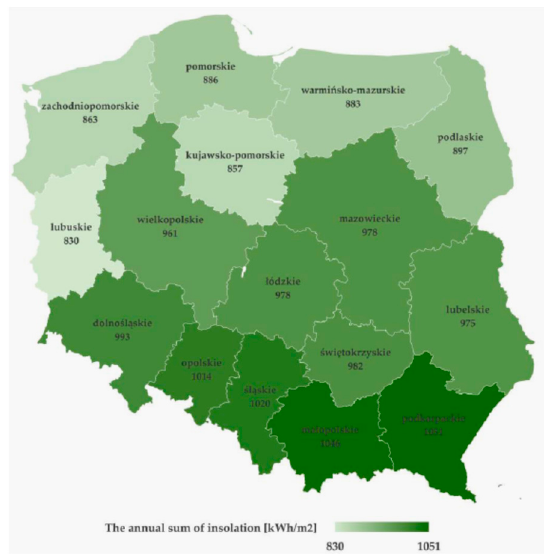
Figure 1. The annual sum of insolation in particular voivodships–data from [58]. Poland’s insolation does not differ greatly from the insolation of Central European countries and areas in similar latitudes. From the point of view of using solar energy by photovoltaic installations, the most important parameter is the annual value of insolation, which defines the quantity of solar energy per unit of flat area in a specified period. When considering this parameter, it can be stated that the solar conditions in Poland differ greatly regionally—the annual density of irradiance fluctuates between 800 and 1200 kWh/ m 2 . Such a number of sunrays is enough to meet 60% (in winter) and 100% (in sum- mer months) of electricity demand [59]. 2.3. Investment Outlays and Operational Costs of Photovoltaic Installations In order to evaluate the economic efficiency of an undertaking, it is necessary to com- pare the level of income (benefits) that results from its implementation with its costs, in- cluding the investment outlays that are related to its creation, according to the NPV method. The evaluation presented in this paper was made with fixed current prices (level of prices from the first half of 2020). The calculations of values of other authors expressed at other levels were updated with the application of the consumer price index [60], as well as the European Union Consumer Price Index (CPI) [61]. The basis for calculating the con- version rate of PLN into Euro was the average exchange rate for the Euro for the first half of 2020 [62]. The value of investment outlays was established based on the level of insolation in a particular region of a given voivodship, in accordance with the values that are presented in Figure 1. The minimum number of panels necessary to meet the total annual demand for electricity, as calculated for the analysed variants fluctuates between eight and 12. Fix- ing such a number of panels, in accordance with the price estimate of a company conduct- ing its business in the whole of Poland equals Euro 3450 (in the case of eight panels fixed to sloping roofs) and up to Euro 5430 (in the case of fixing 12 panels to sloping roofs). Investments relating to solar panel investments are supported by public funds due to the significant social advantages that result from replacing the production of electric energy from coal with solar energy. This support is realised through a system of subsidies, tax relief and preferential loans. One of the support programmes is “My Electricity” (Mój Pr ą d), in the scope of which an investor receives subsidies in the sum of 50% of all instal- lation costs, but no more than Euro 1125. Furthermore, as of 2019, natural persons invest- ing in photovoltaic installations, apart from obtaining subsidies, have the possibility of receiving tax relief when settling their income tax. This solution enables the deduction of